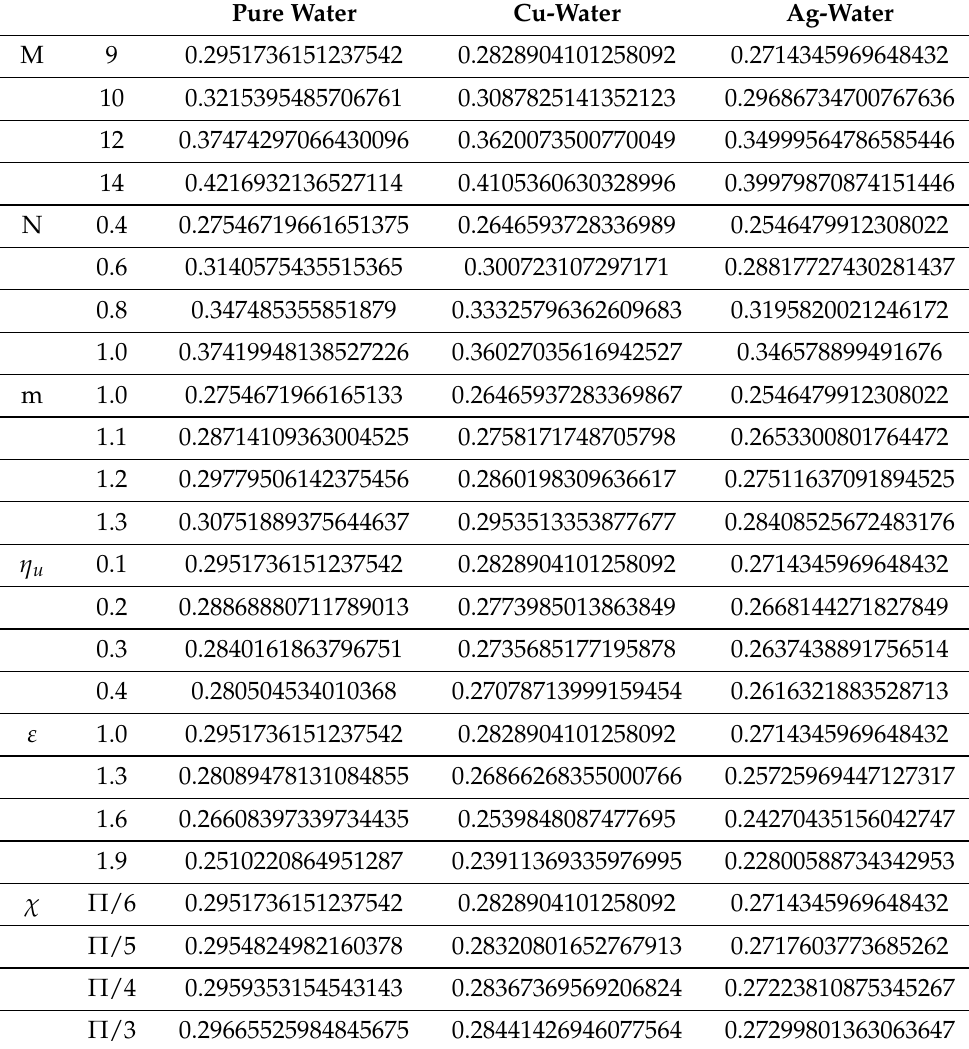
Table 4. Temperature profile Θ ( λ ) at λ = 3 for variation of M, N , m , η u , ε , and χ